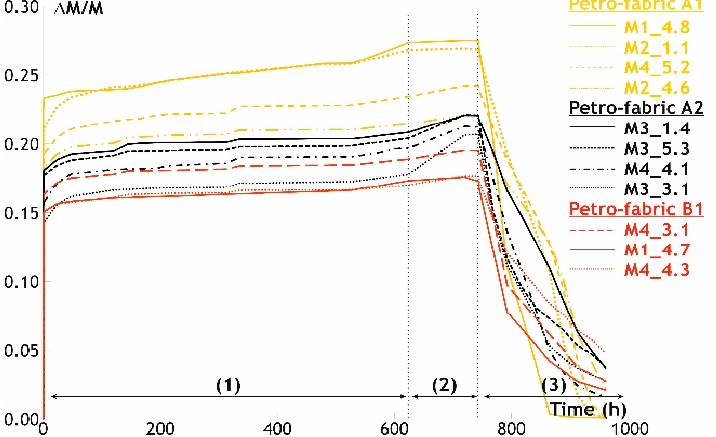
Figure 10. Free water absorption (1), forced water absorption (2) and drying (3) of bricks belonging to petro-fabrics A1, A2 and B1. Weight variation ( ∆ M/M) versus time (in h). Each curve represents the mean of two measurements.